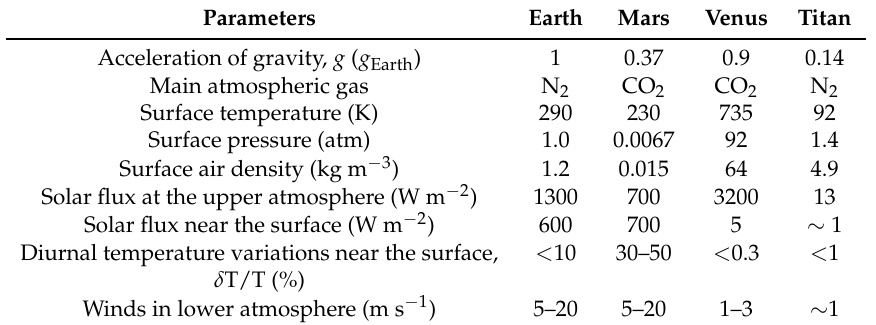
Table 1. Planetary atmospheric environment parameters for Earth, Venus, Mars, and Titan. Data from